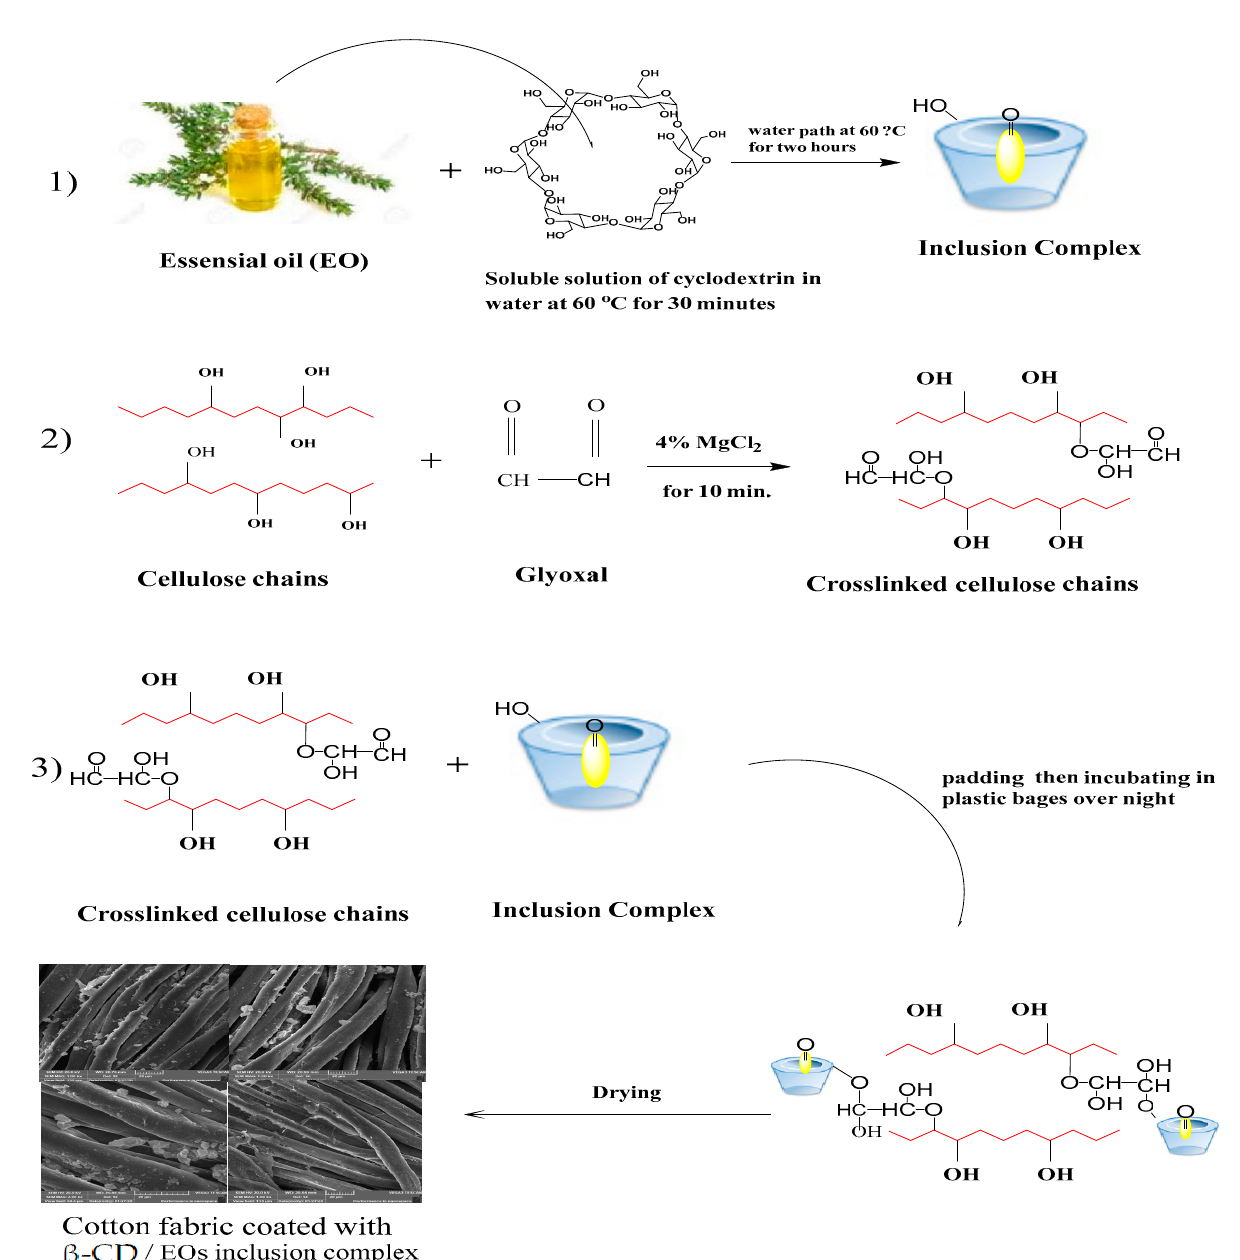
Figure 1. FTIR spectrum of treated cotton fabrics with inclusion complex β -CD-EO S via methods 1 and 2.